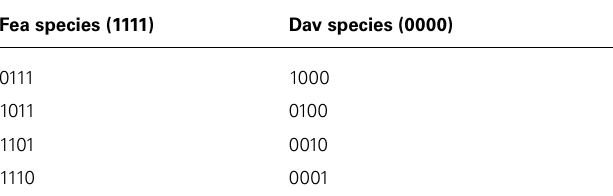
Table 1 |The prototype and exemplar class for each